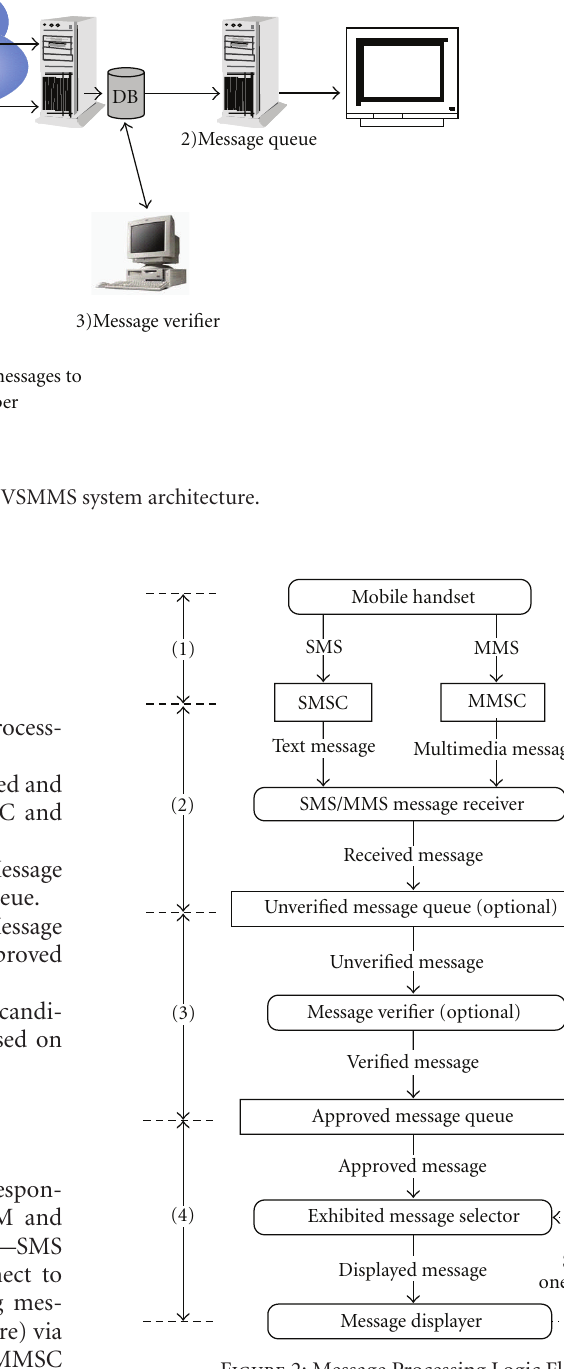
Figure 2: Message Processing Logic